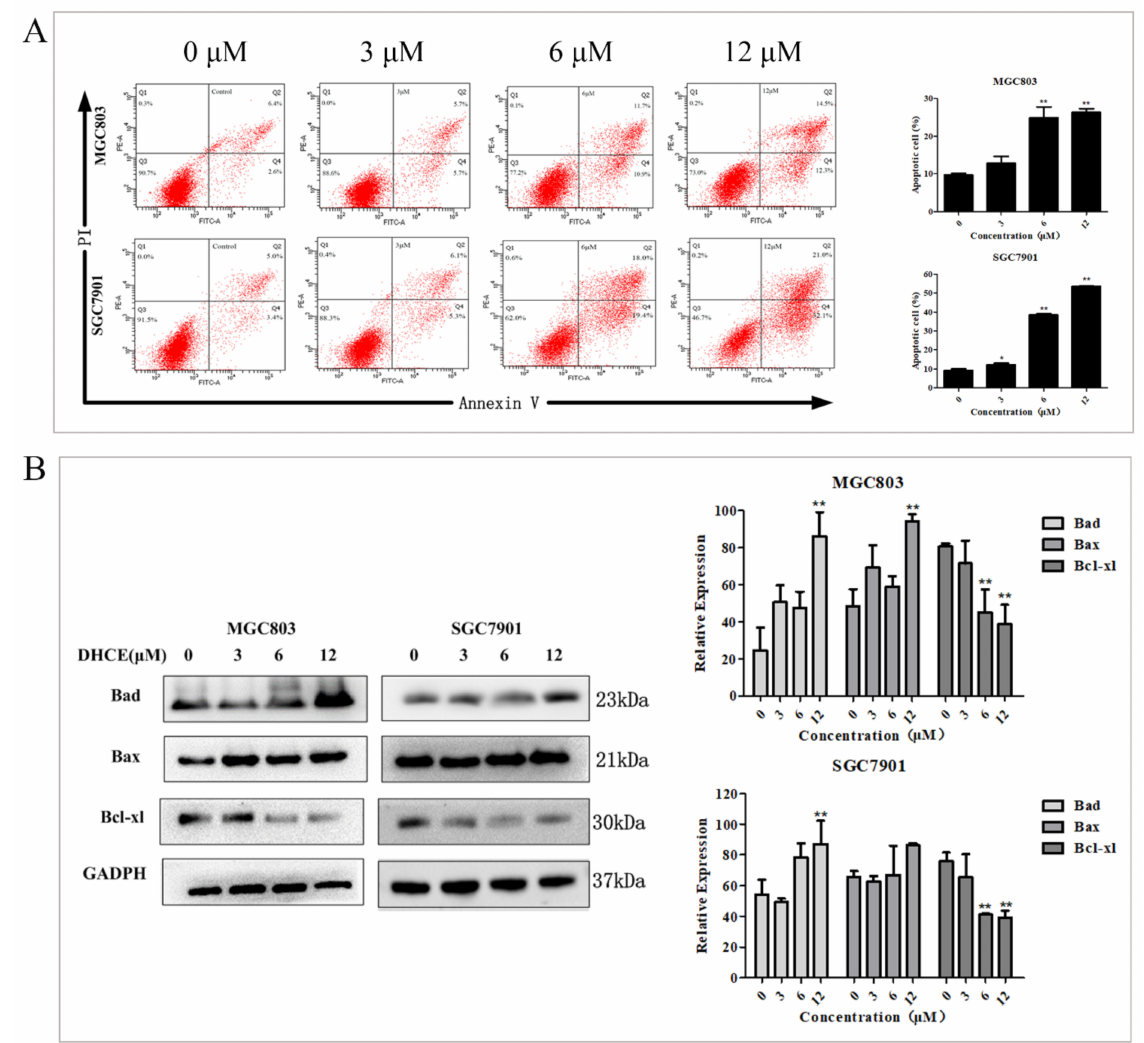
Figure 3. DHCE induced apoptosis of gastric cancer cells. ( A ) MGC803 and SGC7901 cells were treated with different concentrations of DHCE for 24 h, and the apoptosis level was detected by Annexin V-FITC/PI double staining. ( B ) Western blot was used to detect the expression levels of Bad, Bax and Bcl-xl in MGC803 and SGC7901 cells. The experiment was performed in triplicate, and the statistical results are expressed as means ± SD (* p < 0.05 and ** p < 0.01 compared with the control